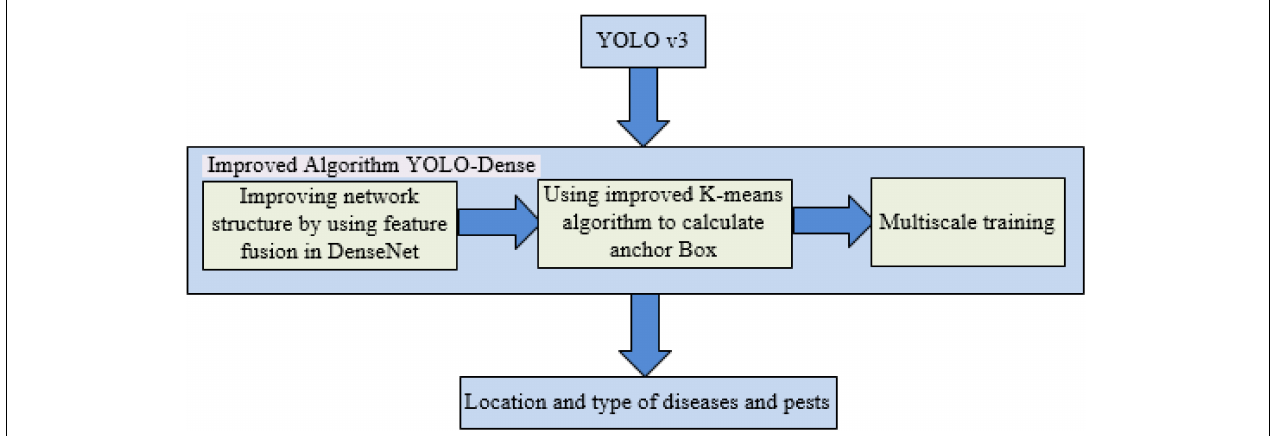
FIGURE 1 | Schematic diagram for improving the YOLOv3 model 2.1 YOLO-Dense network design.